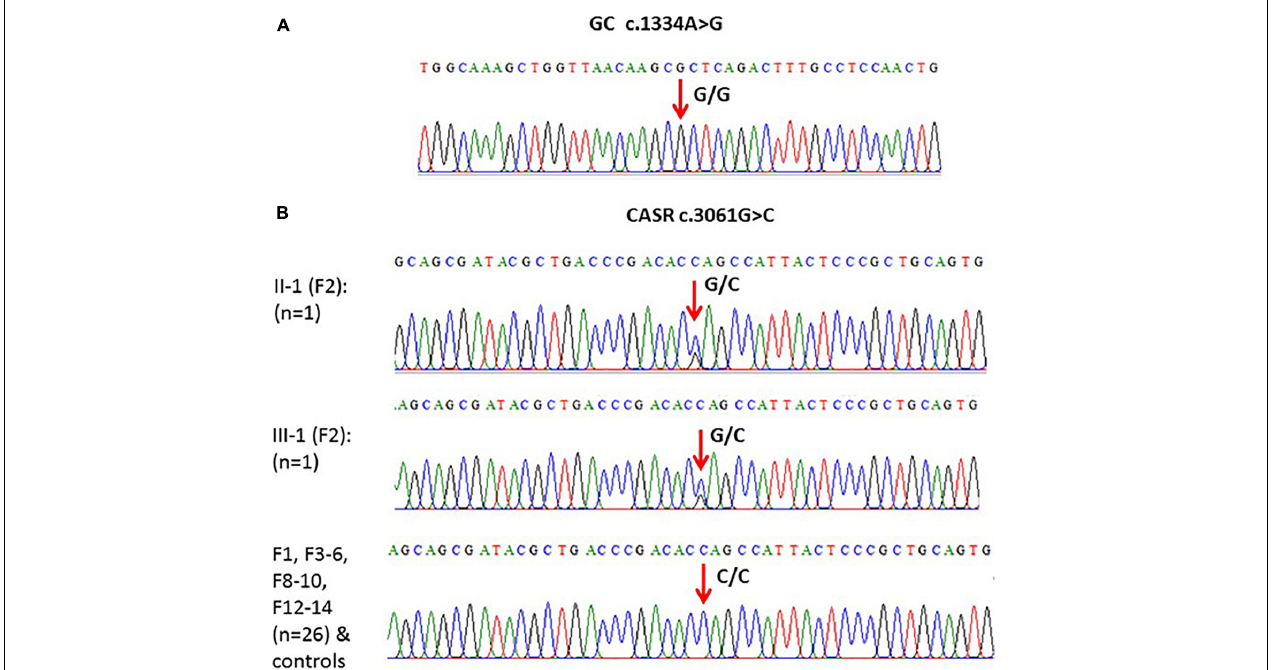
FIGURE 4 | (A) An example of one of the chromatograms that showed c.1334A > G polymorphism (G/G) in the GC gene. (B) Models of elicited Sanger sequencing chromatograms that showed polymorphism (c.3061G > C) in the CASR gene. Homozygous CC was the major genotype, while heterozygous GC was found in F2